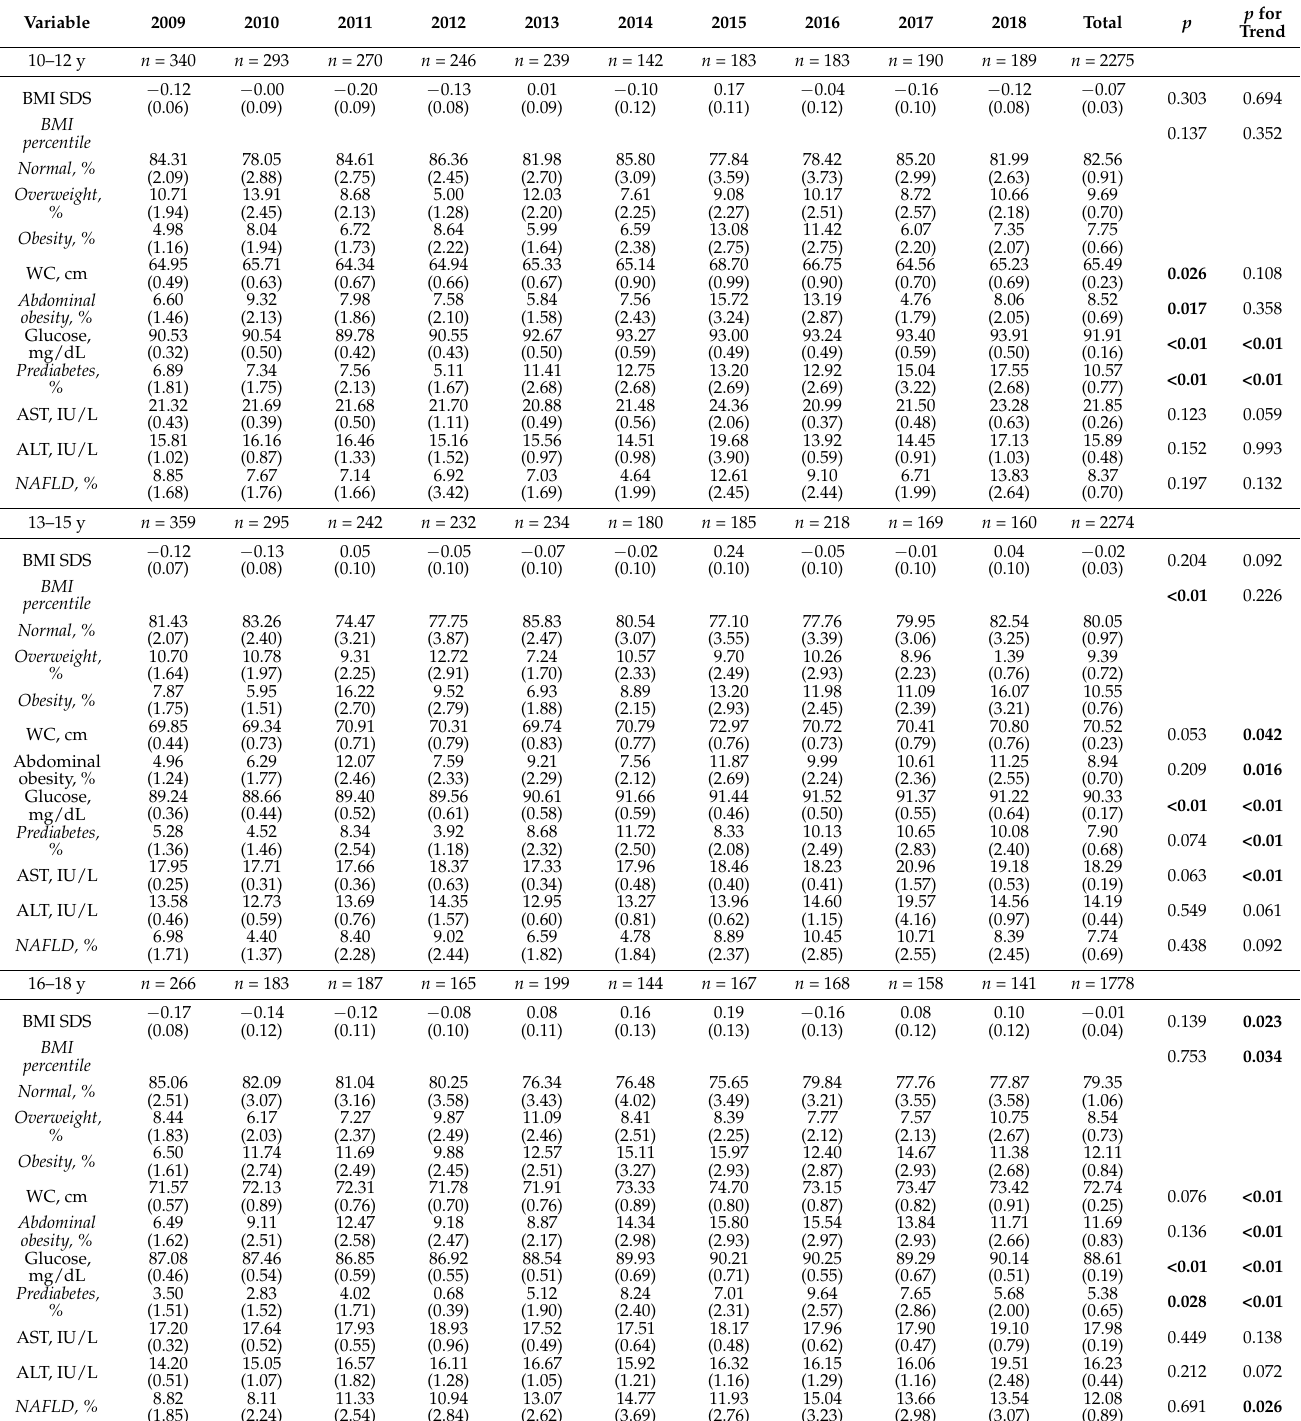
Table 2. Trend of prediabetes of participants according to age